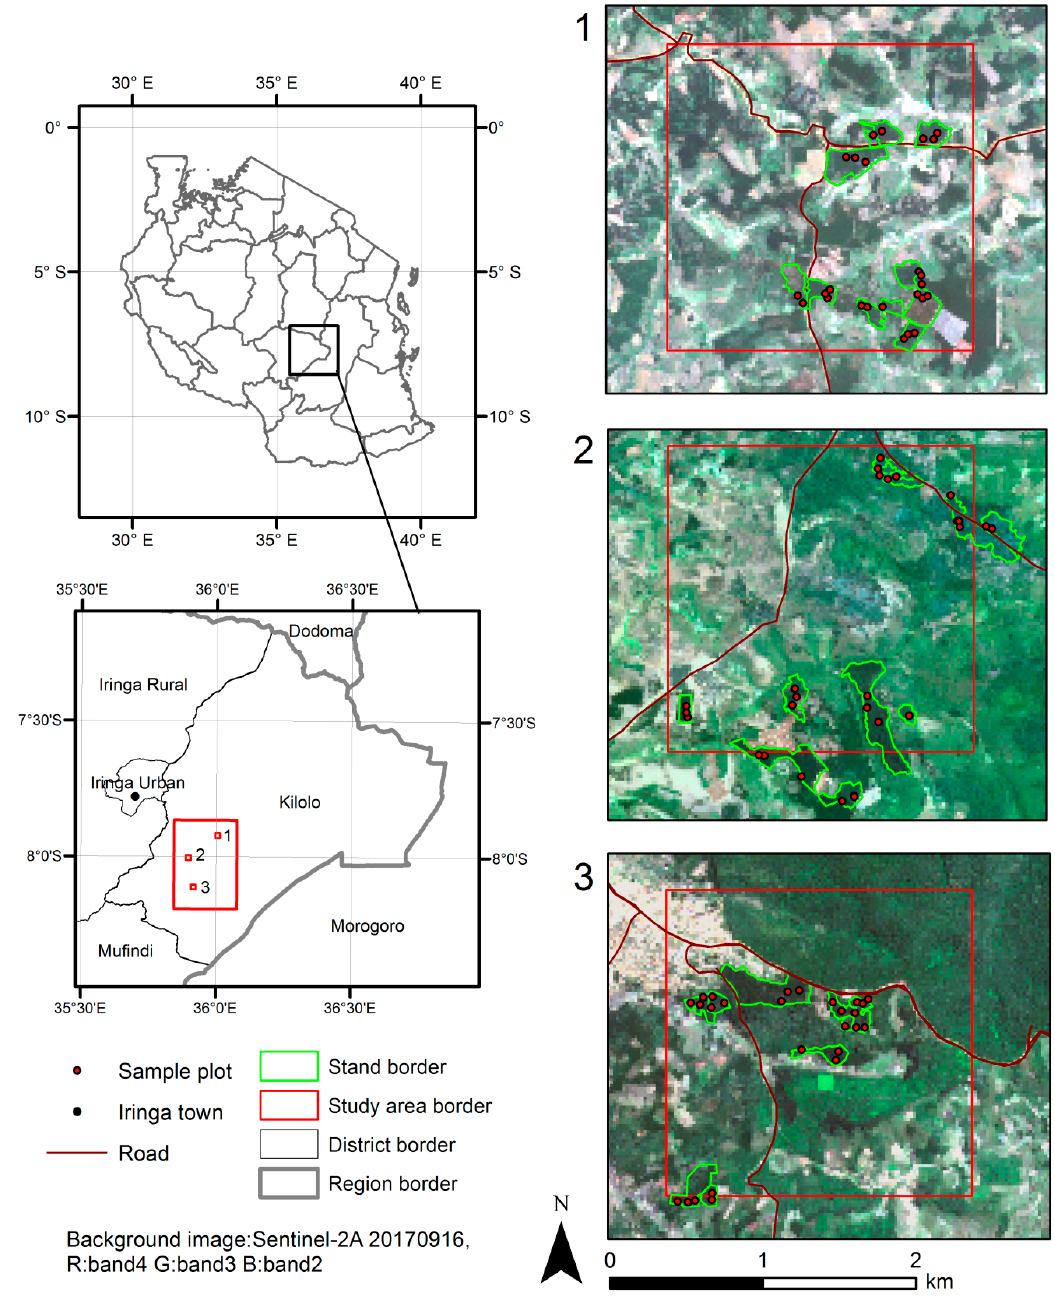
Figure 1. The location of the study area within Kilolo district and the 3 selected 2 km wide windows for sample plots.